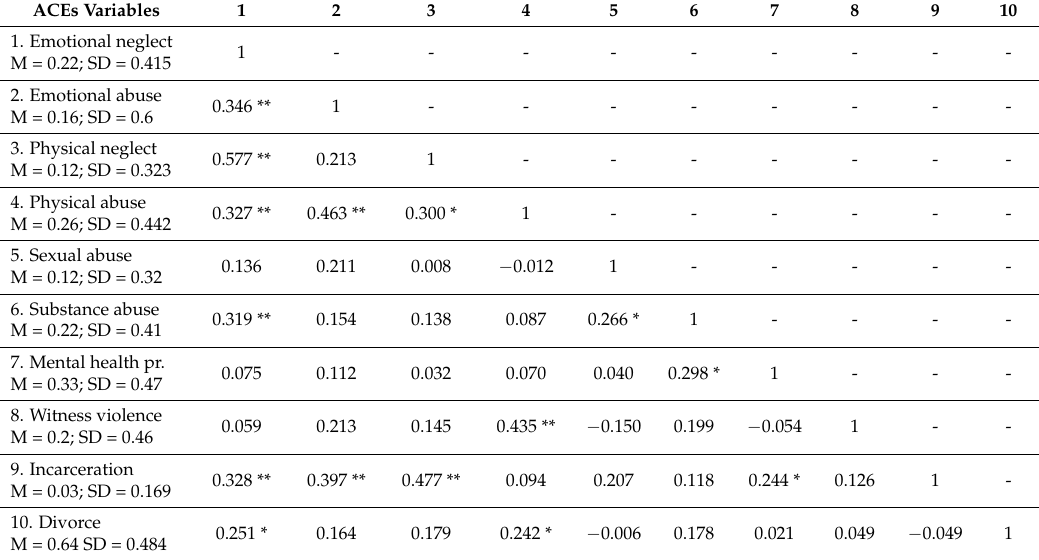
Table 3. Correlation coefficients of the dichotomous original ACEs framework